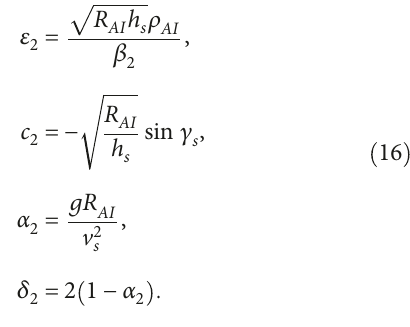
Figure 2: The zero-order solution for aerocapture.